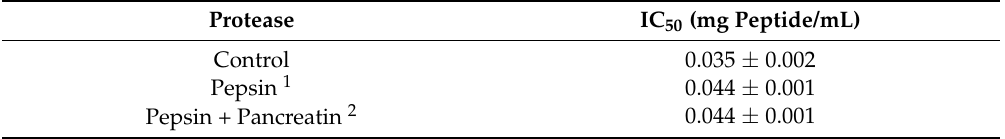
Table 2. Effect of gastrointestinal protease hydrolysis on ACE-inhibitory activity of PN-1. Protease